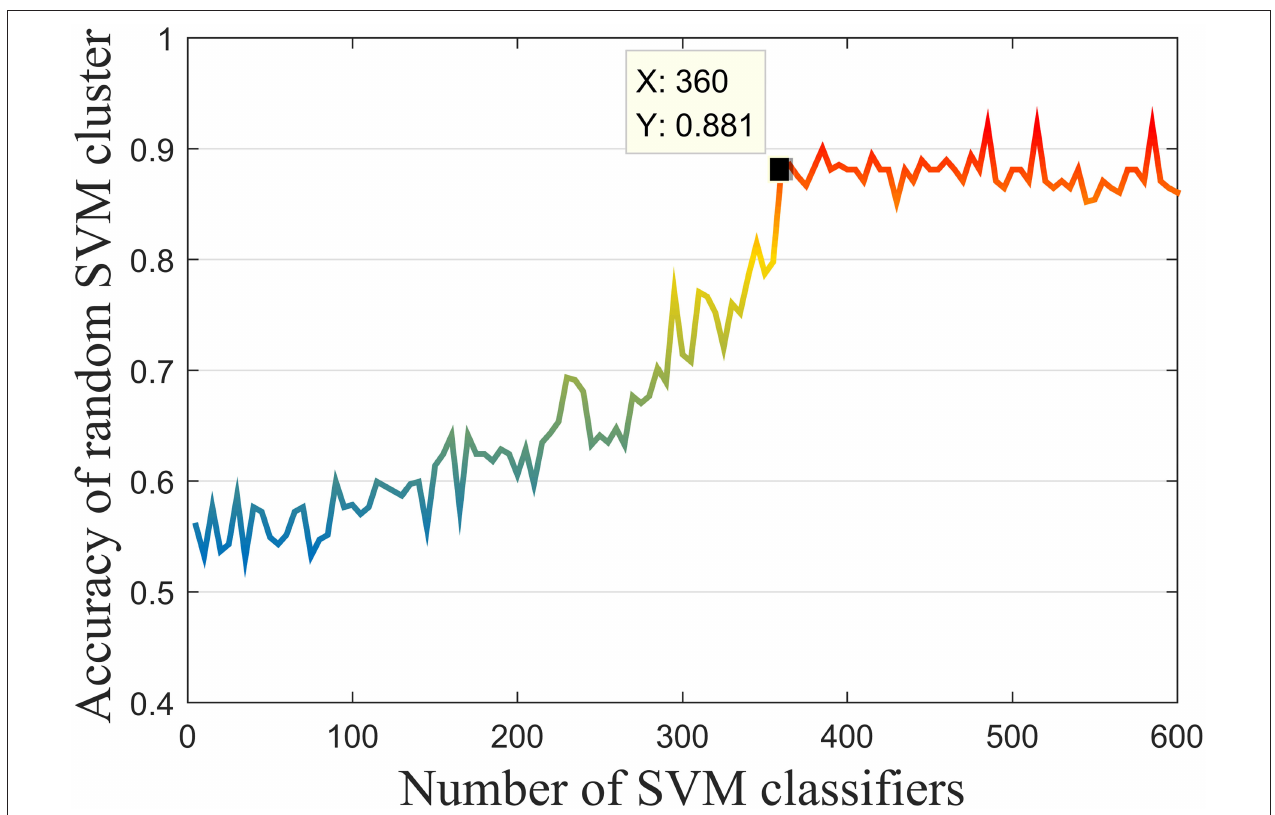
FIGURE 4 | Performance of the random SVM cluster with different number of